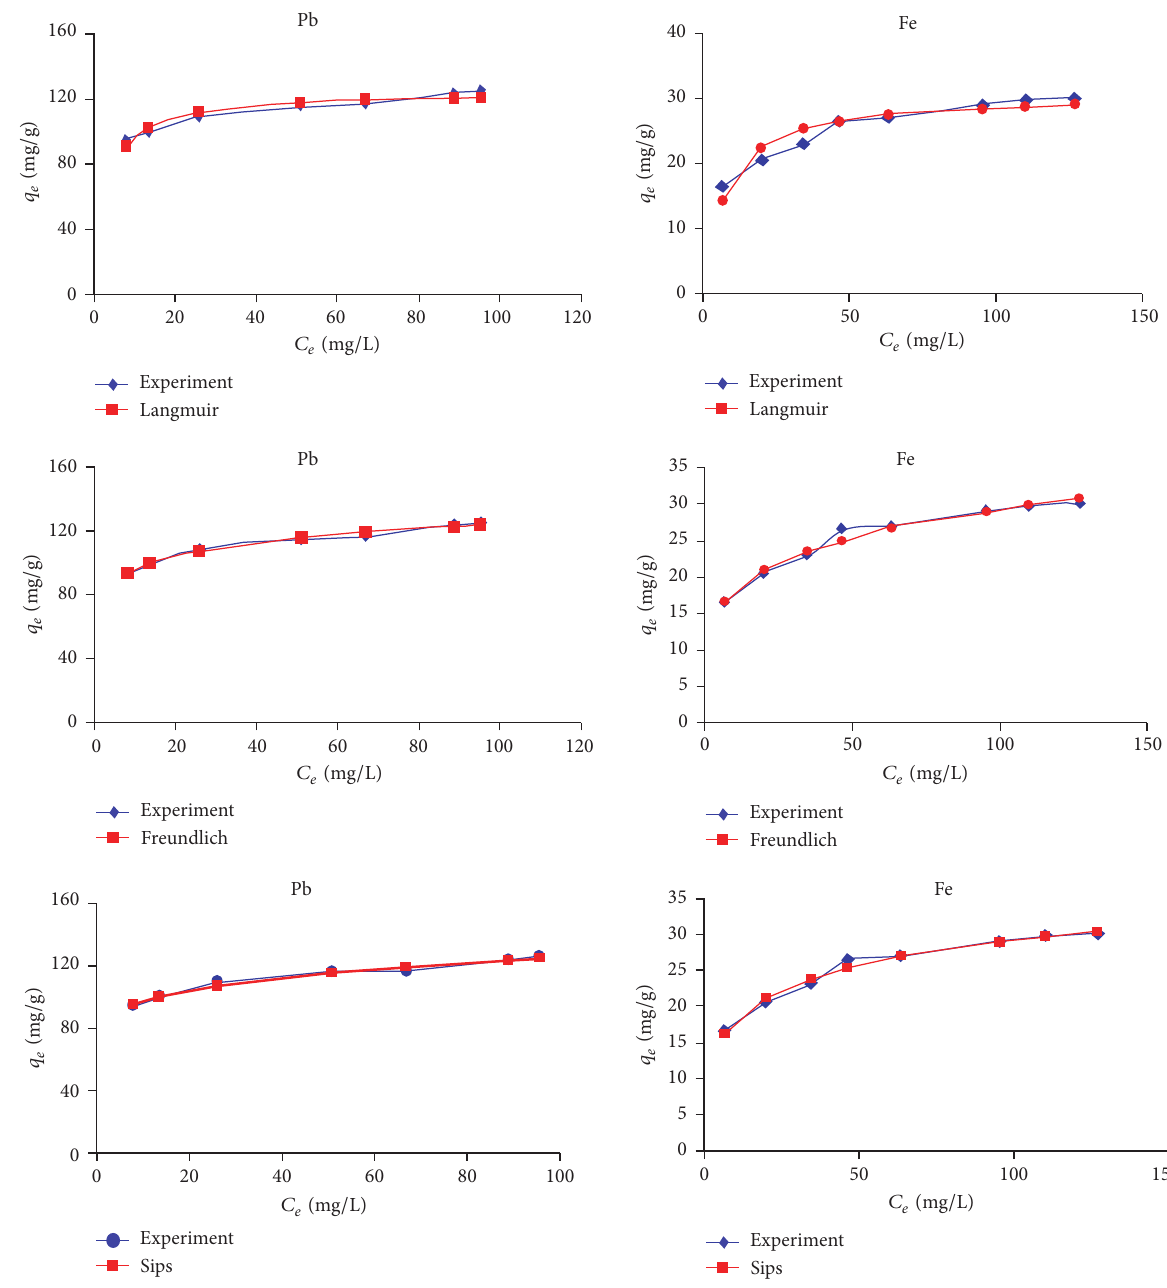
Figure 6: Plots of adsorption isotherm models: Langmuir, Freundlich, and Sips